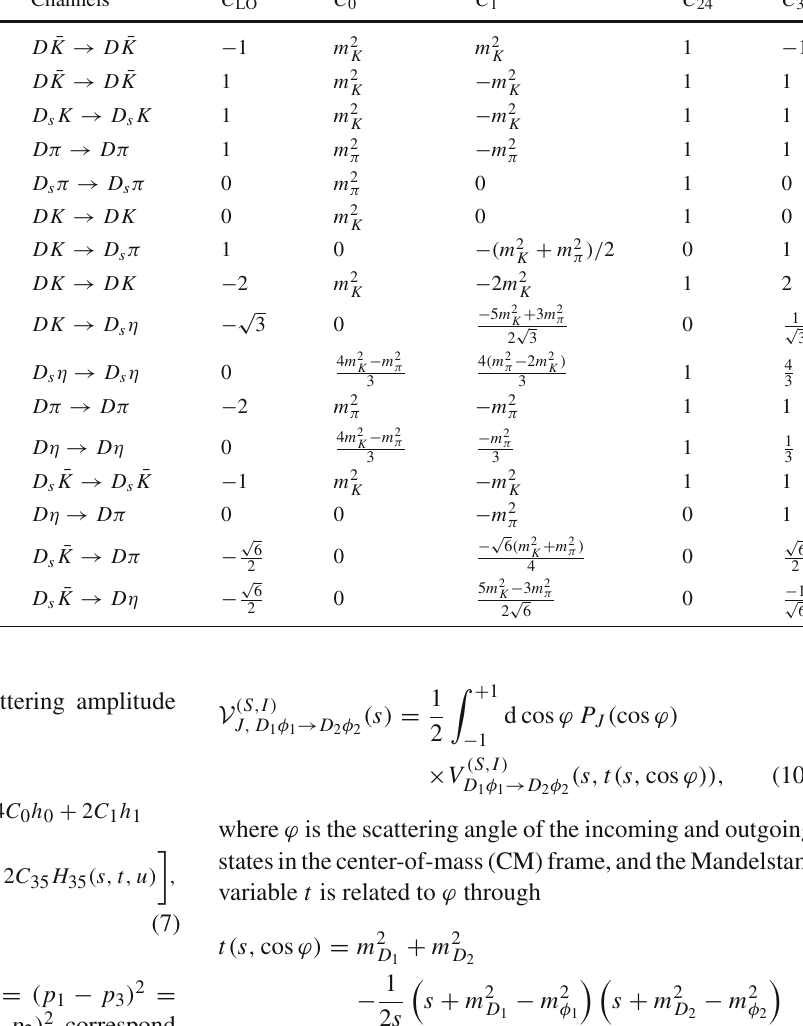
Table 1 The coefficients C i in the